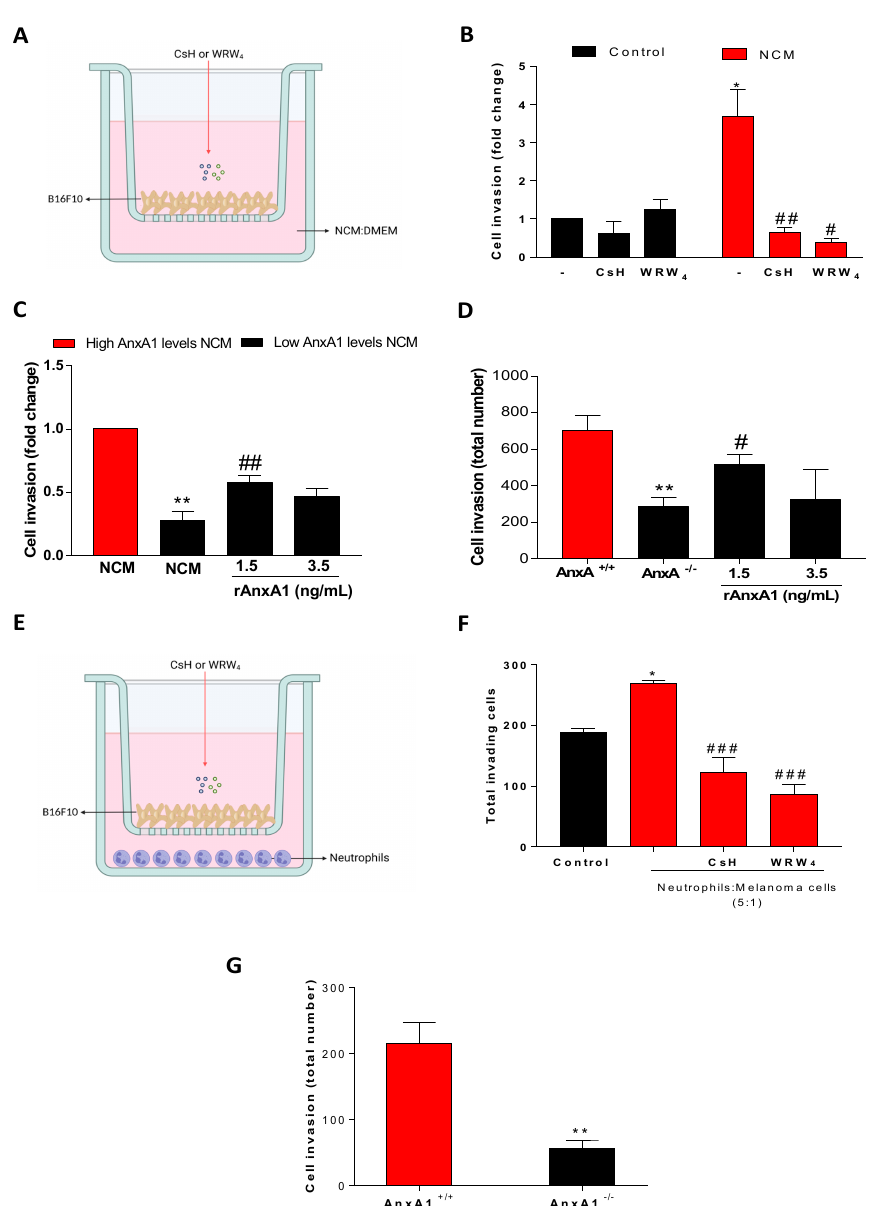
Figure 4. Neutrophil-conditioned medium or neutrophil cultured with melanoma cells increased the cell invasion by in a dependent manner of AnxA1. ( A ) Experimental design. ( B ) Invasion of melanoma cells in the absence and presence of FPR inhibitors incubated with standard culture medium (DMEM supplemented with 5% of FBS–control) or neutrophil-conditioned medium (NCM) for 24 h. Melanoma cells were pre-treated with 1 µ M cyclosporine H (CsH; FPR1 inhibitor) or 1 µ M WRW 4 (FPR2; inhibitor) for 15 min before seeding at the transwell bottom. * p < 0.05 vs. control; # p < 0.05; ## p < 0.001 vs. NCM. ( C ) Invasion of melanoma cells in the presence of NCM—detectable levels of AnxA1, NCM—undetectable levels of AnxA1, or NCM—undetectable levels of AnxA1 supplemented with recombinant AnxA1 (rAnxA1) at indicated concentrations. **/## p < 0.01 vs. NCM. ( D ) Invasion of melanoma cells in the presence of NCM from wild-type (AnxA1 +/+ ) or AnxA1 knockout (AnxA1 -/- ) mice cultured for 24 h. ( E ) Experimental design. ( F ) Invasion of melanoma cells in the absence and presence of FPR inhibitors co-cultured for 24 h with neutrophils at proportion of 5 neutrophils to 1 melanoma cell. * p < 0.05 vs. control; ### p < 0.001 vs. untreated cells. ( G ) Invasion of melanoma cells in the presence of neutrophils from AnxA1 +/+ or AnxA1 -/- mice cultured for 24 h. The data represent the average ± SEM of at least five to eight independent experiments. ** p < 0.01 vs. AnxA1 +/+